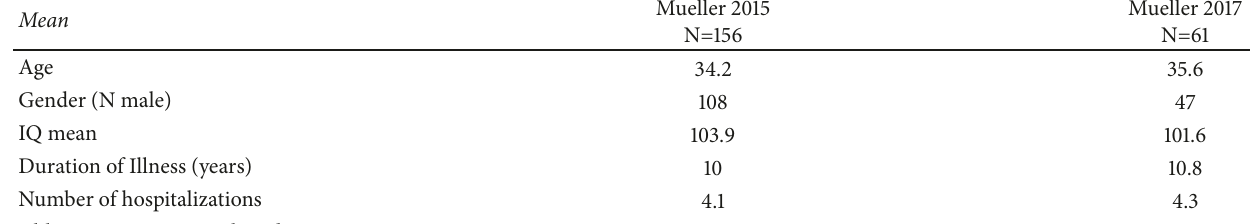
Table 1: Characteristics of the studies.